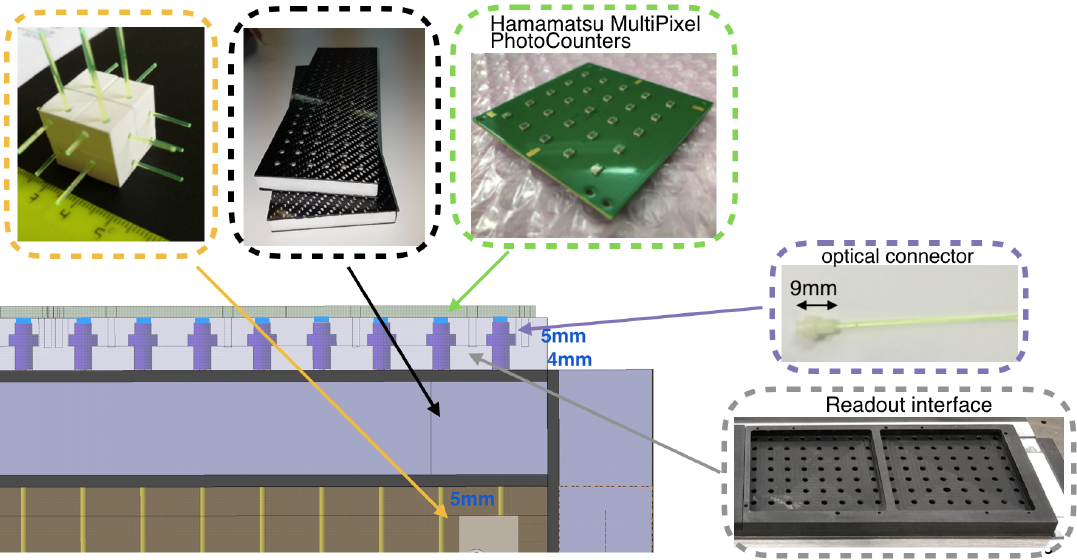
Figure 124. Elements of the light readout system integrated on the CF-based mechanical box are